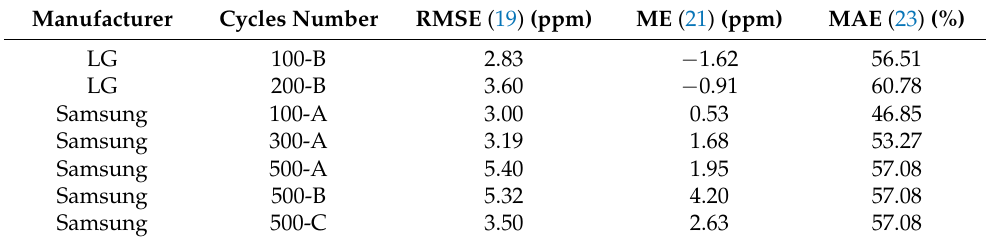
Table 9. Error comparison obtained with the aged cell. Resistance R 0 error